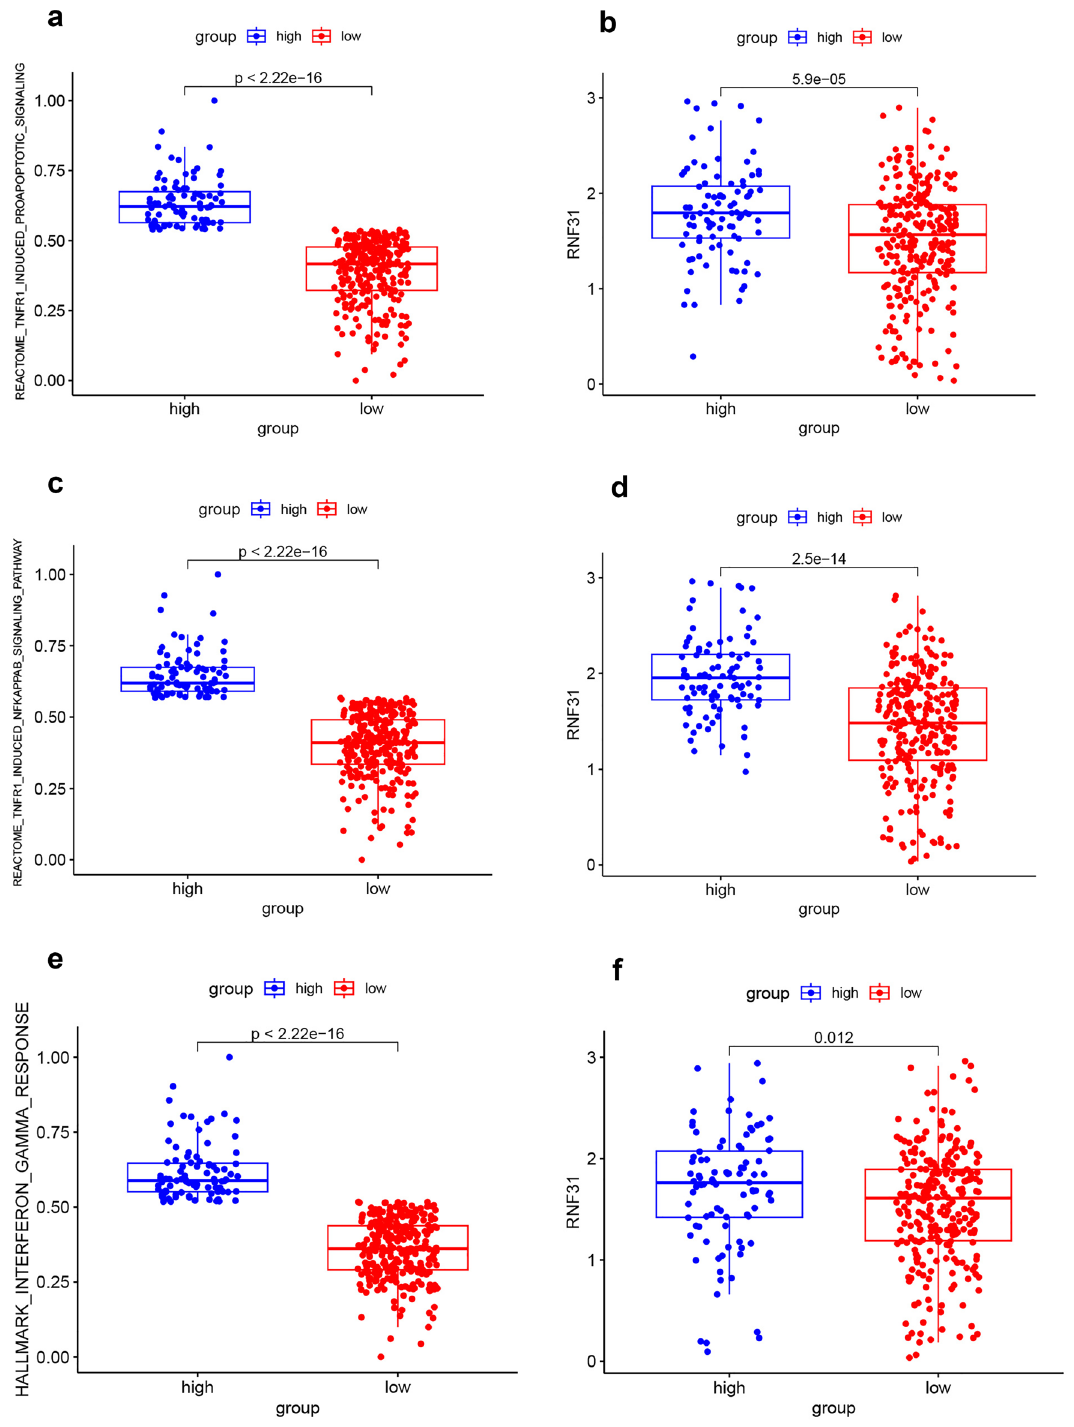
Figure 7. The relationship between TNF and IFN-γ pathways and RNF31 expression. ( a – b ) Differences in "REACTOME_TNFR1_INDUCED_PROAPOPTOTIC_SIGNALING" pathway ssGSEA scores and RNF31 expression between the two groups (patients with pathway ssGSEA scores below the third quartile were assigned to the “low” group, and patients with scores above the third quartile were assigned to the “high” group). ( c – d ) Differences in "REACTOME_TNFR1_INDUCED_NFKAPPAB_SIGNALING_PATHWAY" pathway ssGSEA scores and RNF31 expression between the two groups (patients with pathway ssGSEA scores below the third quartile were assigned to the “low” group, and patients with scores above the third quartile were assigned to the “high” group). ( e – f ) Differences in "HALLMARK_INTERFERON_GAMMA_RESPONSE" pathway ssGSEA scores and RNF31 expression between the two groups (patients with pathway ssGSEA scores below the third quartile were assigned to the “low” group, and patients with scores above the third quartile were assigned to the “high”